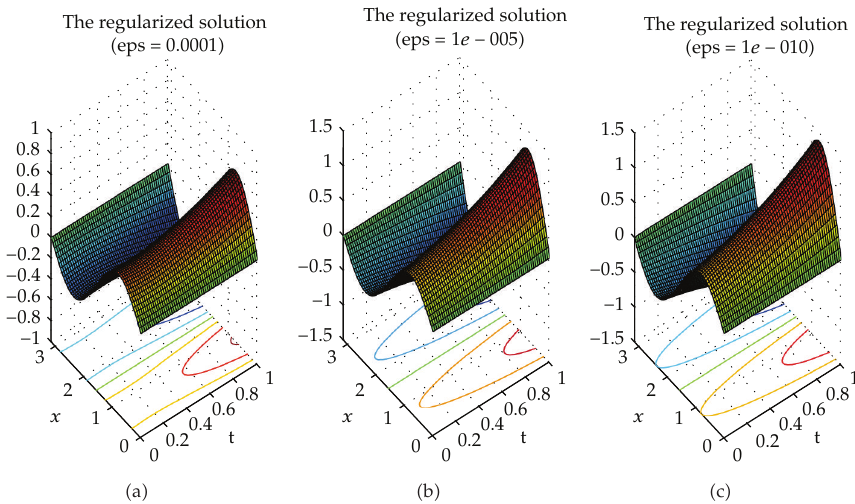
Figure 2: The regularized solutions corresponding to δ i , i (cid:5) 4 , 5 ,